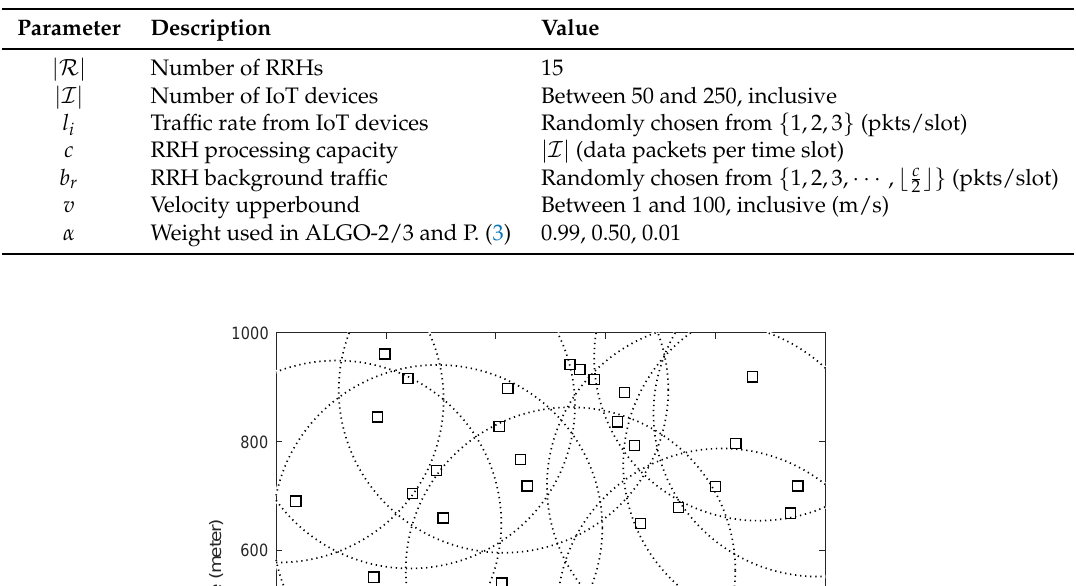
Table 3. Network parameters.